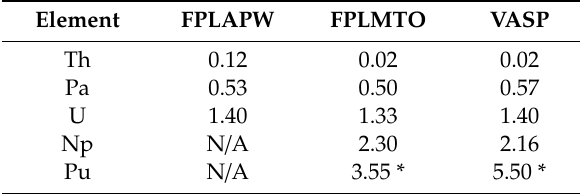
Note: * includes spin–orbit coupling and orbital